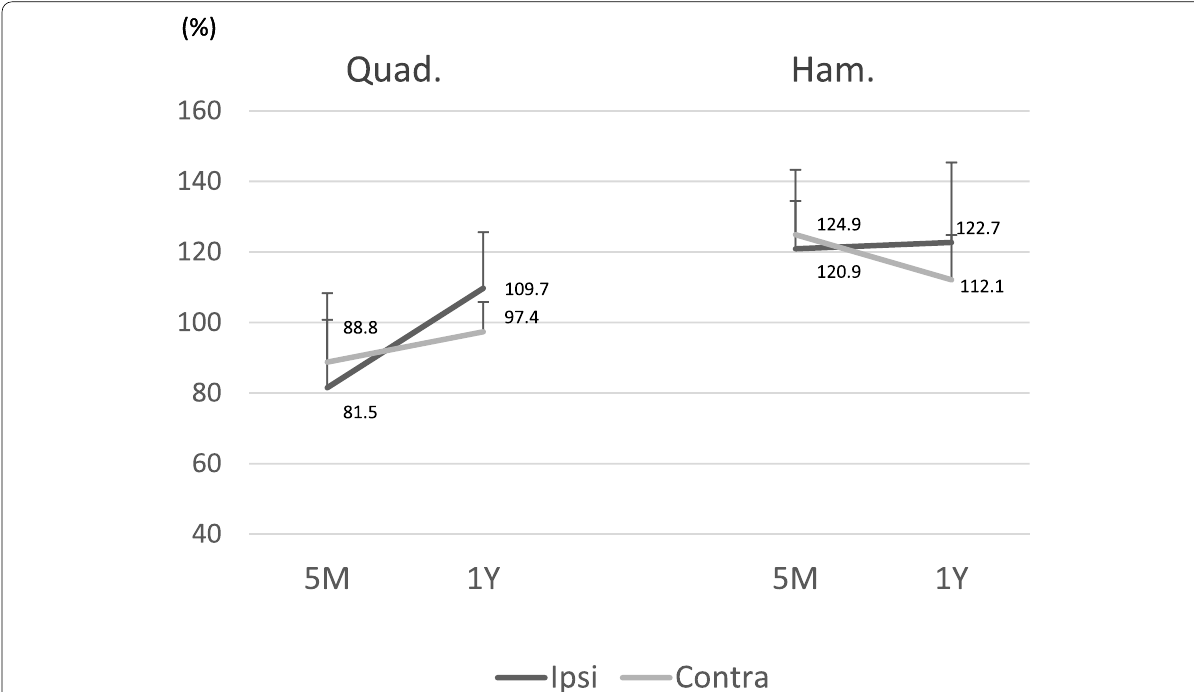
Fig. 2 Muscle strength recovery of the BTB reconstructed knees in relation to the preoperative normal knees was investigated. No significant difference was noted in the quadriceps muscle strength between the two groups at 5 months (Quad.: 88.8 19.5% in the C-BTB vs. 81.5 19.1% ± ± in the I-BTB; p 0.38, Ham.: 124.9 9.5% in the C-BTB vs. 120.9 24.0% in the I-BTB; p 0.48) and 12 months (Quad.: 97.4 8.4% in the C-BTB vs. = ± ± = ± 109.7 18.3% in the I-BTB; p 0.12, Ham.: 112.1 12.8% in the C-BTB vs. 122.7 34.6% in the I-BTB; p 0.12) after ± = ± ± =